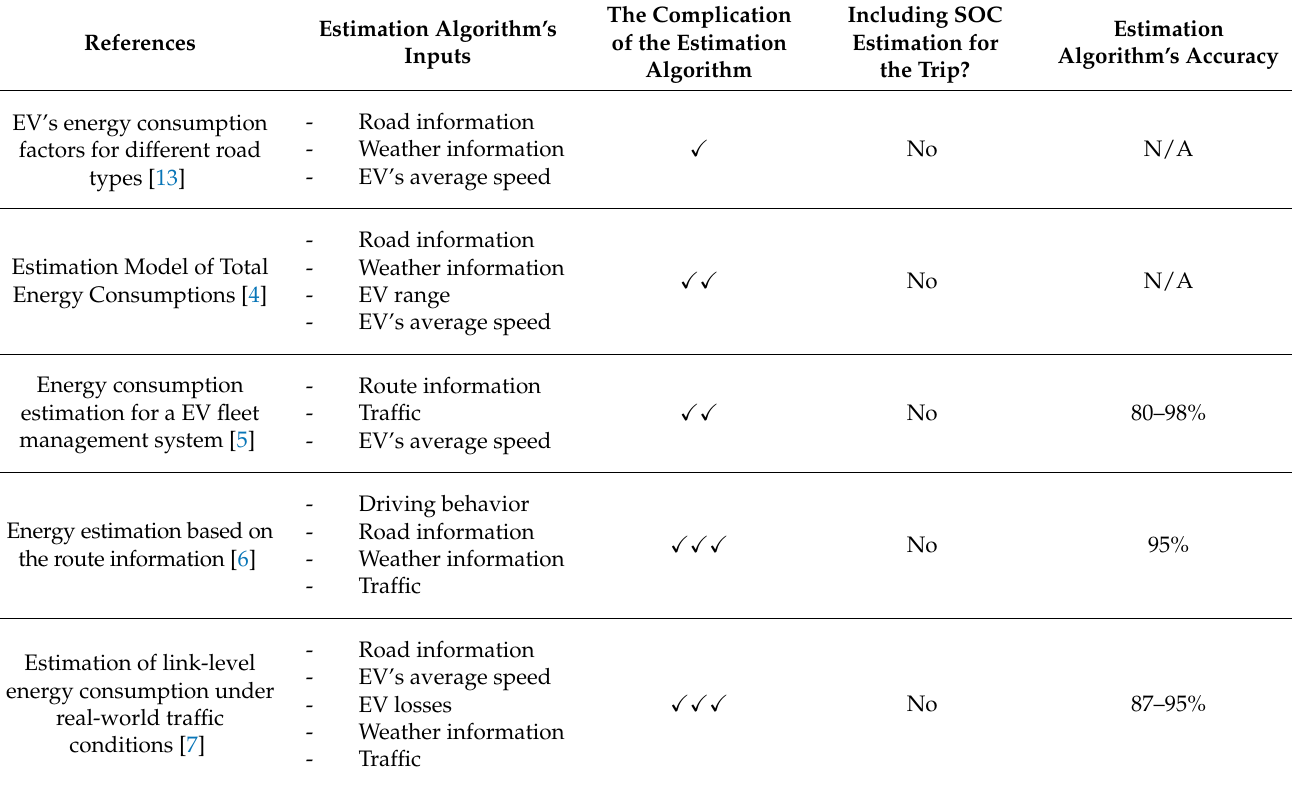
Table 1. EV’s energy consumption estimation algorithm comparison from the